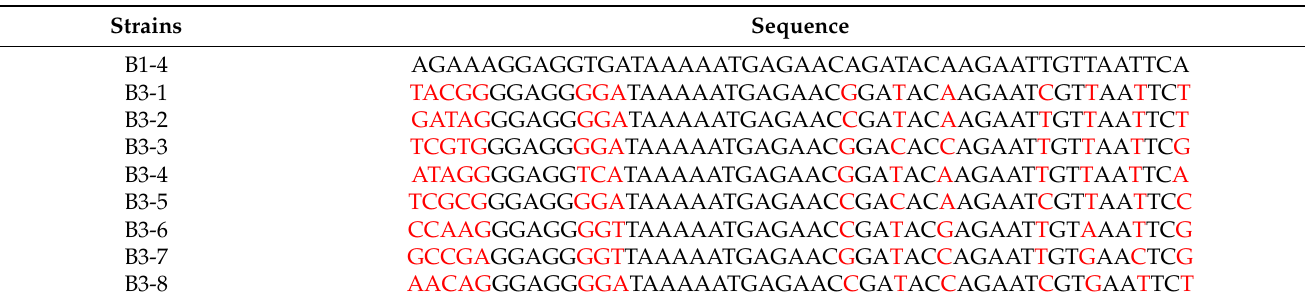
Table 3. The table shows the sequence of different